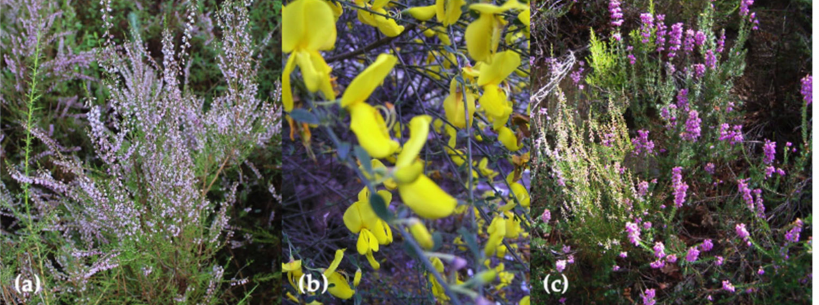
Figure 4. Heliophile shrubs with fine texture and fast combustibility. ( a ) Calluna vulgaris ; ( b ) Cytisus scoparius ; and ( c ) Erica cinerea